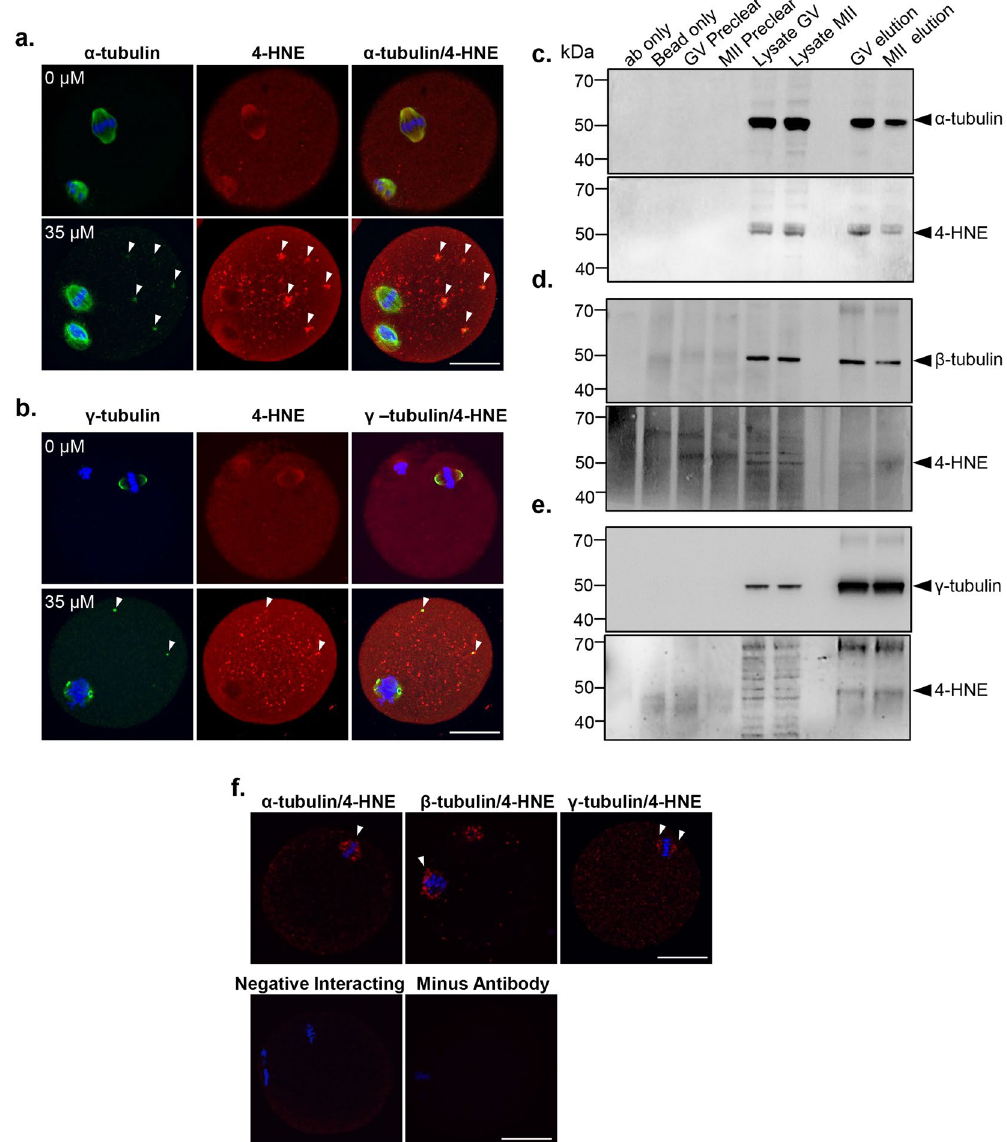
Figure 6. Examination of α -, β - and γ -tubulin/4-HNE interaction in GV and MII oocytes. Co-localisation, immunoprecipitation and PLA experiments were employed to examine the interaction between tubulins and 4-HNE. ( a ) For co-localisation, GV oocytes were untreated or treated with 35 μ M H 2 O 2 for 1 h and then underwent IVM in preparation for fixation at MII. α -tubulin (green) co-localised with 4-HNE (red) at the MII spindle before and after treatment with 35 μ M H 2 O 2 . Notably, 4-HNE aggregates also co-localised microtubule asters (white arrows). Scale bar = 20 μ m. ( b ) γ -tubulin (green) also co-localised with 4-HNE (red) at the poles of the MII spindle before and after treatment with 35 μ M H 2 O 2 . ( c–e ) For immunoprecipitation assays, lysates from H 2 O 2 -treated GV and IVM MII oocytes were incubated with protein G Dynabeads conjugated with anti- tubulin antibodies. The Dynabeads were then washed and proteins that bound were eluted for immunoblotting on two mirrored membranes. One membrane (panel 1) was probed with anti-tubulin antibodies confirming the effectiveness of the immunoprecipitation. The alternate membrane was probed with 4-HNE antibodies (panel 2). Whole oocyte lysate was used as a positive control. Antibody-only control (ab only) and preclear elute negative controls were used to confirm specificity of elution. ( f ) PLA between 4-HNE and α -, β - or γ -tubulin revealed fluorescent foci at the MII spindle indicating an intimate association between 4-HNE and tubulins. Scale bar = 20 μ m. Nuclei were counterstained with Hoechst (blue). Experiments were performed with three biological replicates with each replicate comprising between 10–30 oocytes pooled from a minimum of three animals. Immunoprecipitation experiments was performed in technical duplicate from between 350–500 oocytes pooled from between 8–12